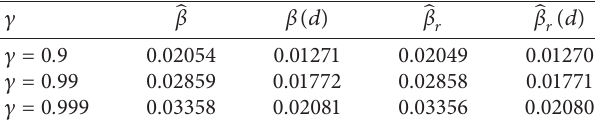
Table 5: The estimated MSE of the estimators when n � 400. c 􏽢 β β ( d ) 􏽢 β